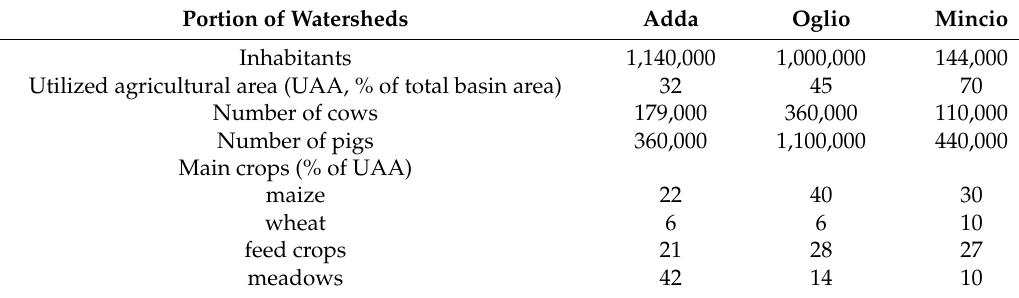
Table 2. Data on farming and irrigation practices in the studied portions of the three basins. Data source: